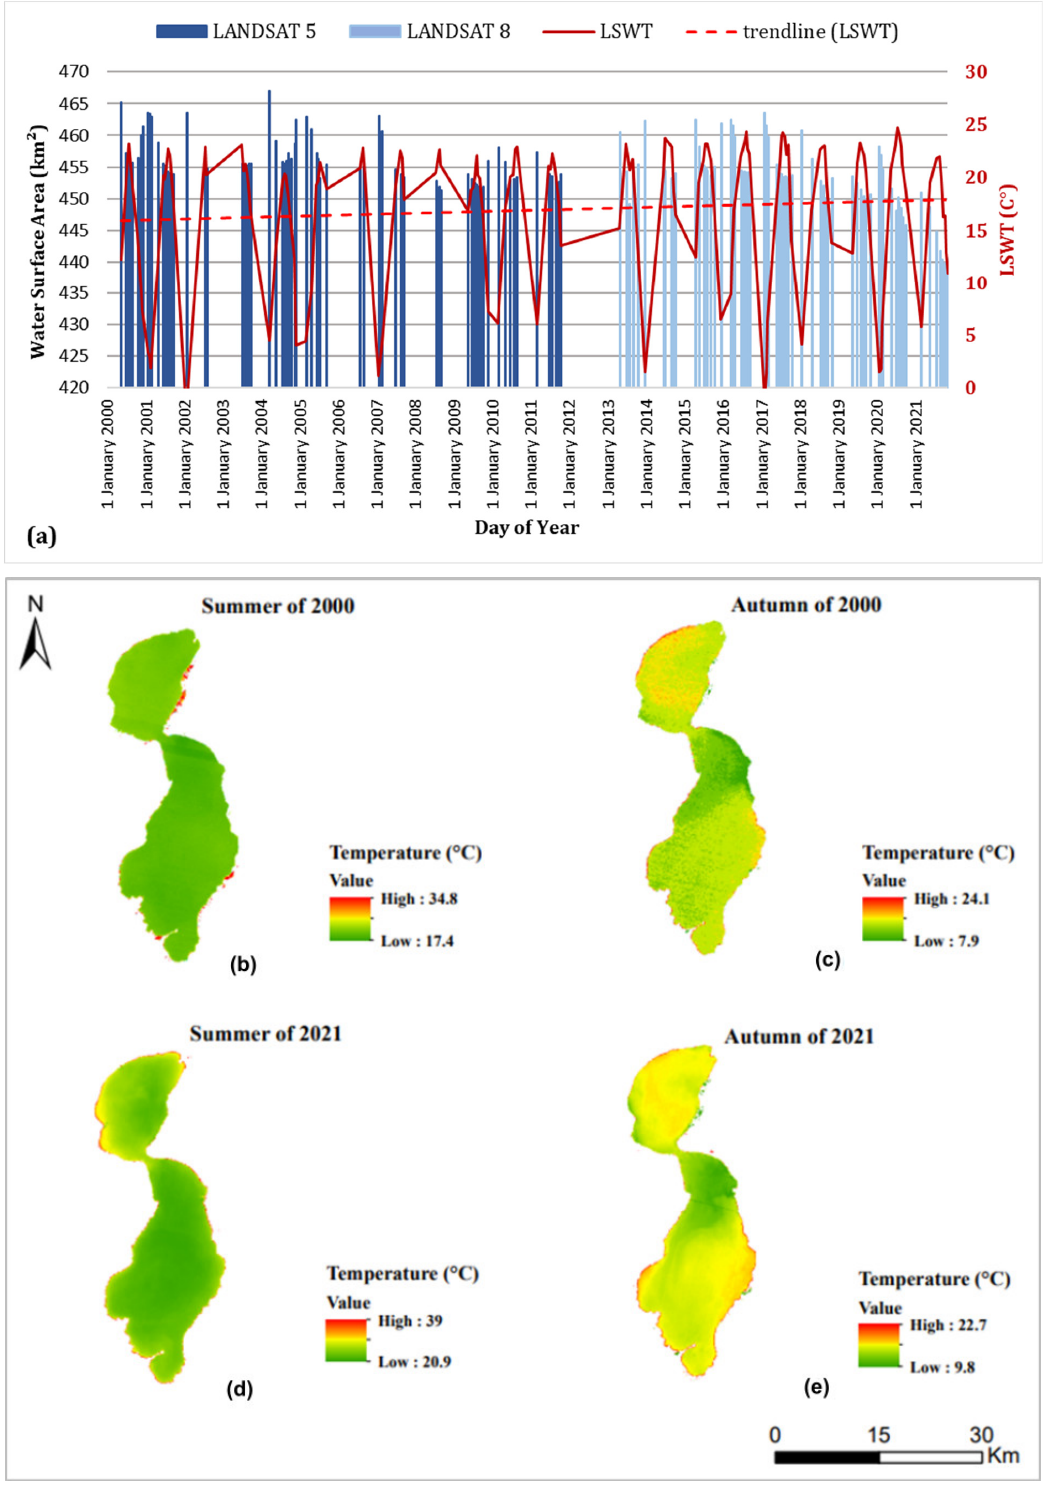
Figure 13. ( a ) The temporal changes in water extent of Egirdir Lake with the LSWT variable. The spatial changes of lake’s surface area with LSWT for: ( b ) summer 2000, ( c ) autumn 2000, ( d ) summer 2021, and ( e ) autumn 2021.